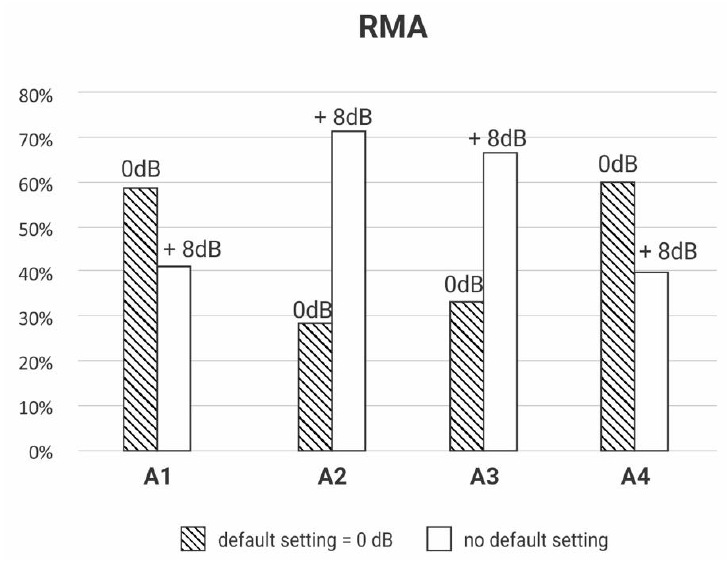
Figure 3. Descriptive analysis of RMA’s receivers’ (A1, A2, A3, A4) gain setting to achieve transparency ( n = 80).